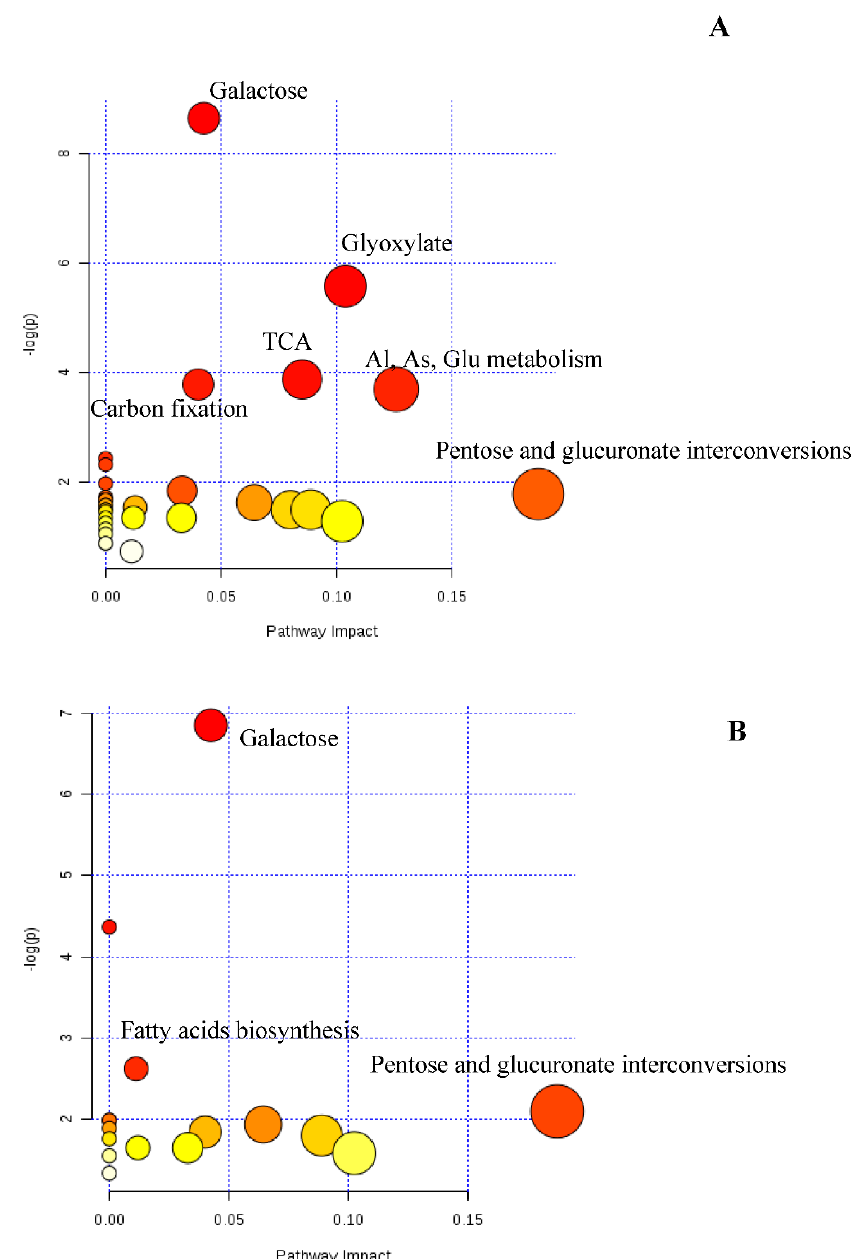
Figure 8. Map of enriched metabolic pathways from differential metabolites of Quercus pubescens leaves; rain exclusion versus control during spring ( A ) and summer ( B ). Topological analysis of impact factors and the p value by pathway enrichment analysis. The color intensity (white to red) indicates the increasing p value, while the circle diameter covaries with pathway impact. Table 5. Targeted metabolomics of the trimethylsilyl/ethoxime (TMS) derivatized organic acids and sugars from leaf extracts of Quercus pubescens . * According to the NIST (National Institute of Standards and Technology) database. Data of the ratios are means of five independent extractions. E, rain exclusion; C, control; n.d., no data. No change is considered for a fold change of one.